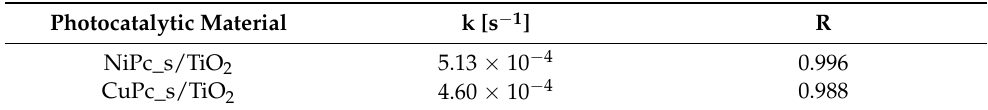
Table 6. The SMX degradation reaction rate constants (first-order reaction model) under UV irradia- tion with Pc-grafted TiO 2 composites in DMF (Figure S9).